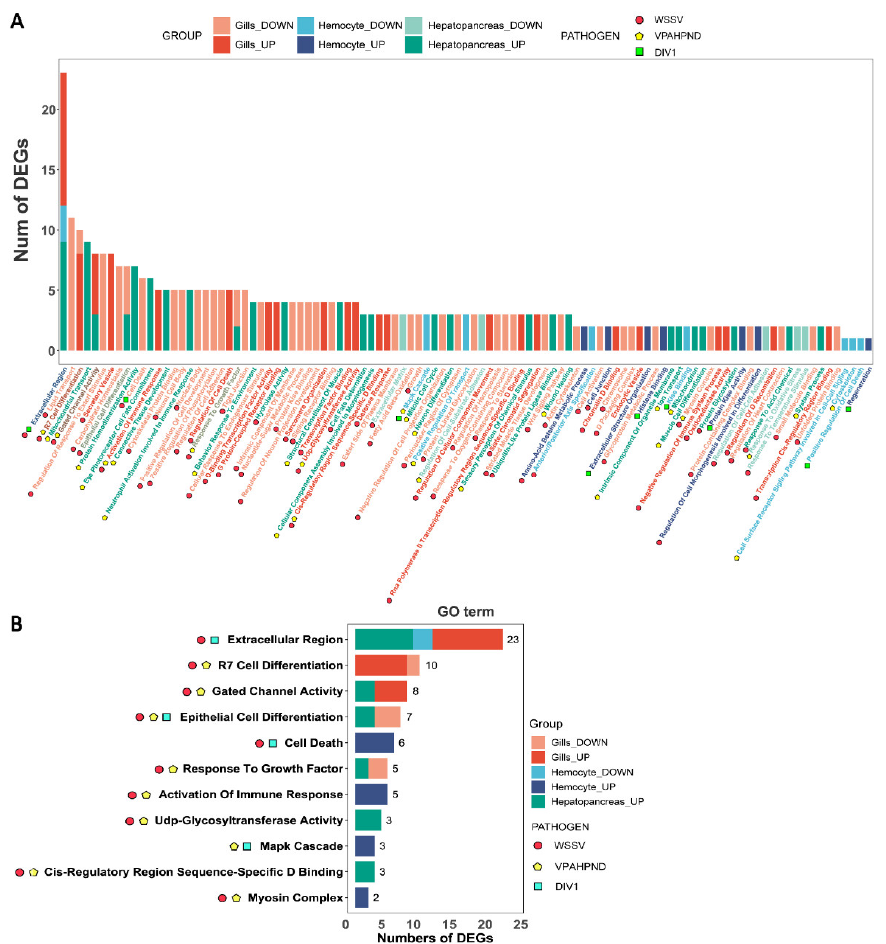
Figure 2. ( A ) Distribution of GO terms in all DEGs annotated in the gills, hemocytes, and hepatopancreas of P. vannamei under WSSV, VPAHPND, or DIV1 infection. ( B ) GO terms of DEGs in the gills, hemolymph, and hepatopancreas that are shared between at least two of the three pathogen infections. The colors of the bars represent the tissue types and expressional changes (down- or up-regulated). The icons next to the KEGG level 3 categories indicate the types of infection.